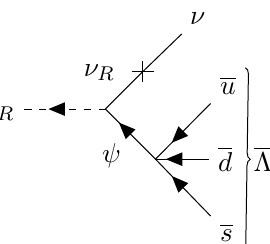
Figure 4. Decay of the right-handed sneutrino DM particle into three light (anti)quarks (which hadronize into i.e. a (cid:22)(cid:3) baryon) and a neutrino. The process is mediated by an o(cid:11)-shell bino and right-handed neutrino, as well as the RPV coupling (cid:21) 00 baryon